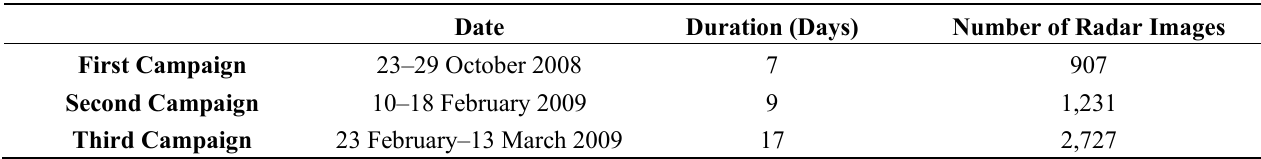
Table 2. Ground-Based Interferometric Sysnthetic Aperture Radar (GB-InSAR) survey